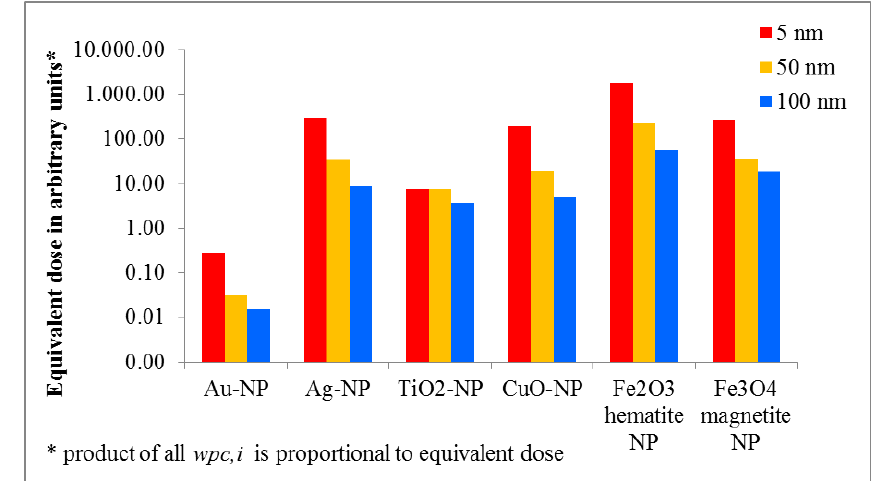
Figure 7. Comparison of the “equivalent dose” described by the product of all w for PC,i different NPs. The tables specify the w for each NP of 5, 50 and 100 nm diameter: ( a ) PC,i different metal and metal oxide NPs, and ( b ) for SWCNTs and MWCNTs. Note that in ( b ) Fe-ions of the dissolving Fe-oxide NPs play a key role in the Fenton reaction seen as a main source of ROS induction in biological systems, leading to oxidative stress. The tables indicate the calculation of the “equivalent dose”. For w we either presumed a zeta PC,3 potential below 6 mV leading to a w value of 1 or a zeta potential of >15 mV leading to PC,3 a w value set to 10 in the absence of detailed information. PC,3